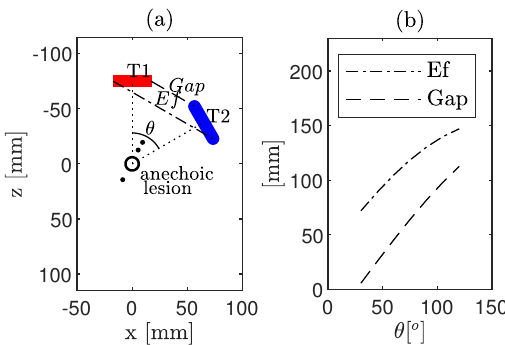
Figure 3. ( a ) Schematic representation of the spatial location of the two linear arrays, T1 (red) and T2 (blue), three point-like targets and the anechoic lesion in the local coordinate system of T1. Different geometrical parameters are shown: angle between probes ( θ ) and the gap ( Gap ) in the resulting effective aperture ( Ef ). ( b ) Associations between θ , Gap and the resulting Ef